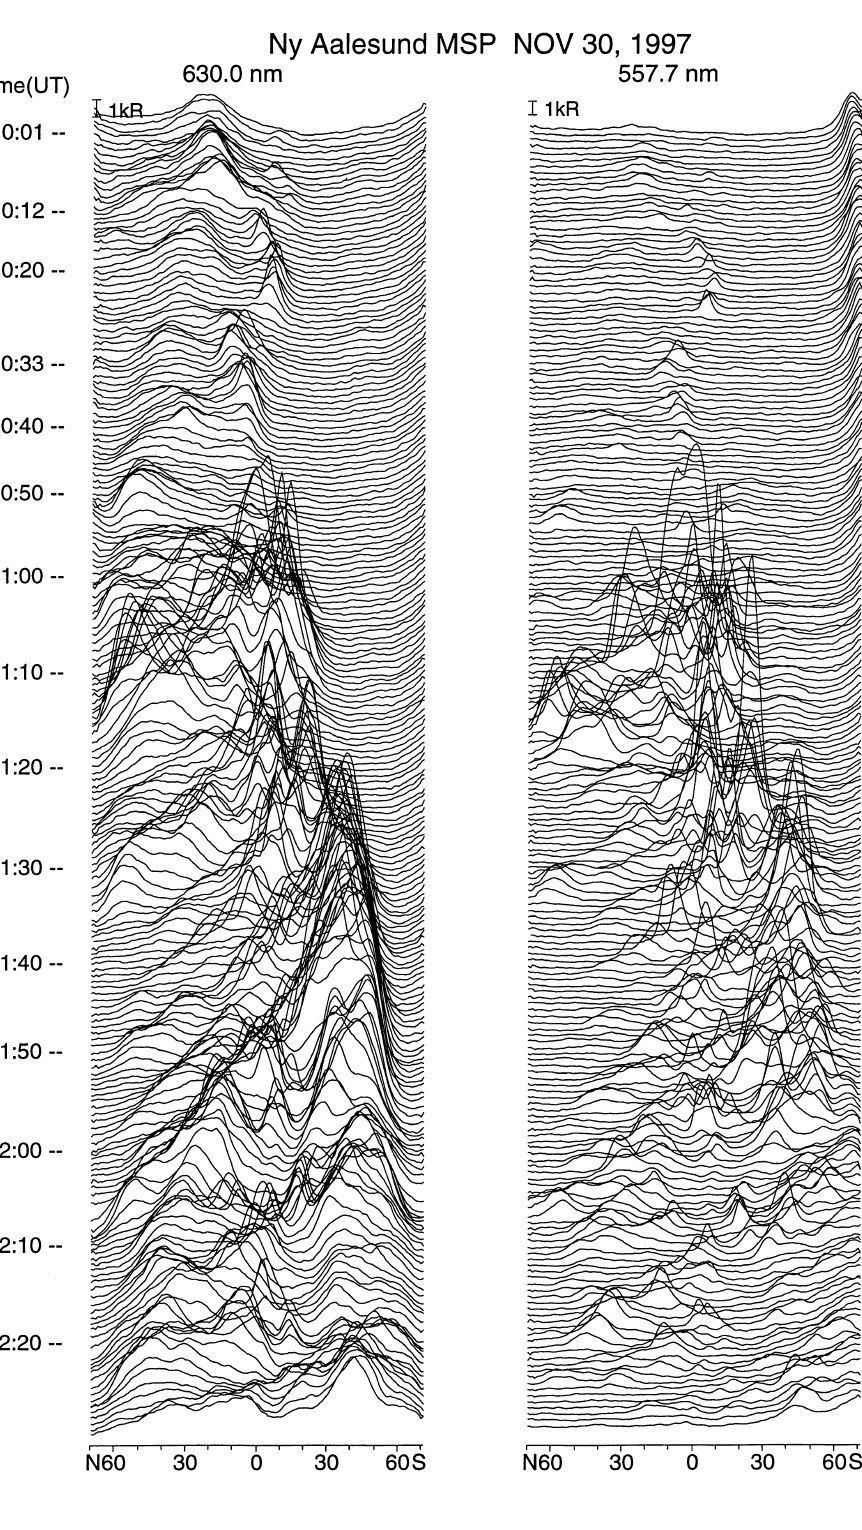
Fig. 2. Meridian scanning photome- ter (MSP) plots of auroral observa- tions from Ny A˚ lesund (at 630.0 and 557.7 nm) during the interval 1000– 1230 UT on November